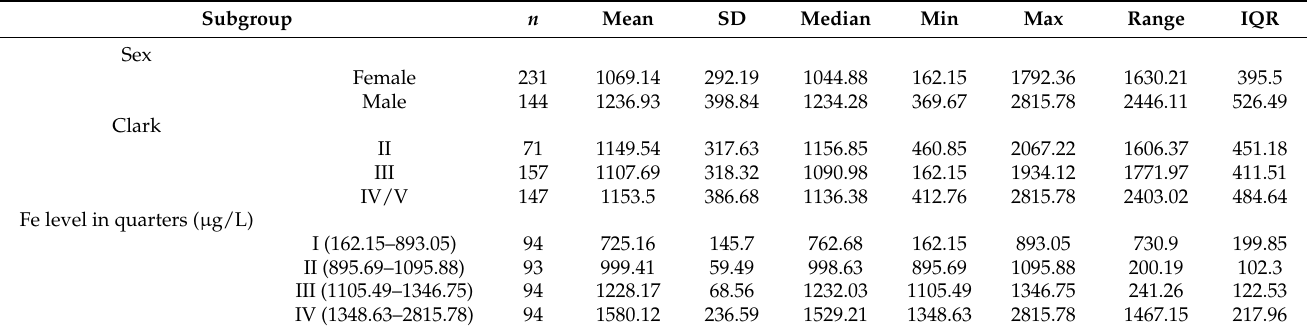
Table 2. Fe levels by subgroups ( n = 375).